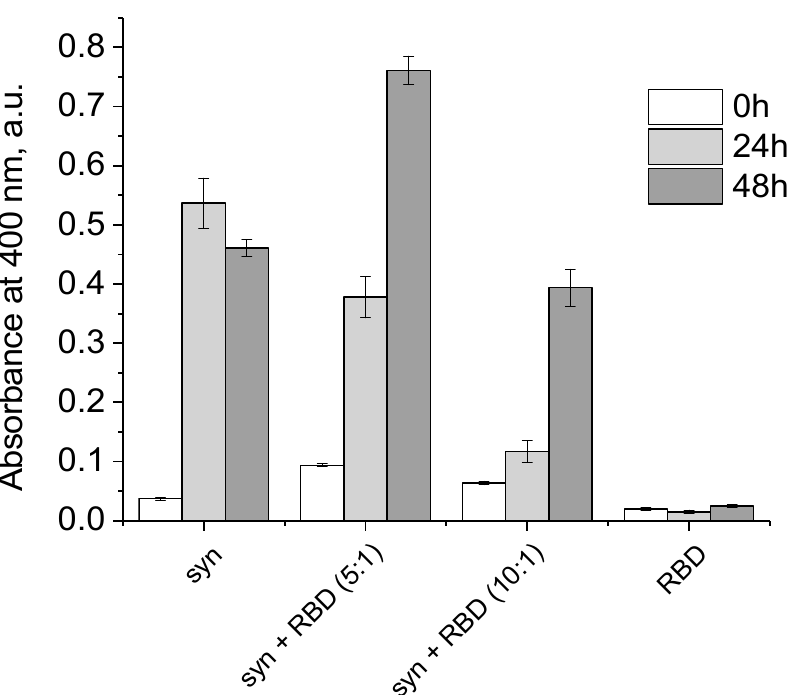
Figure 7. Aggregation of the alpha-synuclein, fibrillized in the presence of SARS-CoV-2 RBD. Ab- sorbance at 400 nm of 5.6 µ M SARS-CoV-2 RBD, 28 µ M alpha-synuclein, 28 µ M alpha-synuclein and 5.6 µ M SARS-CoV-2 RBD (molar ratio 5:1), and 28 µ M alpha-synuclein and 2.8 µ M SARS-CoV-2 RBD (molar ratio 10:1) for 0 h (white), 24 h (light gray), and 48 h (dark gray).